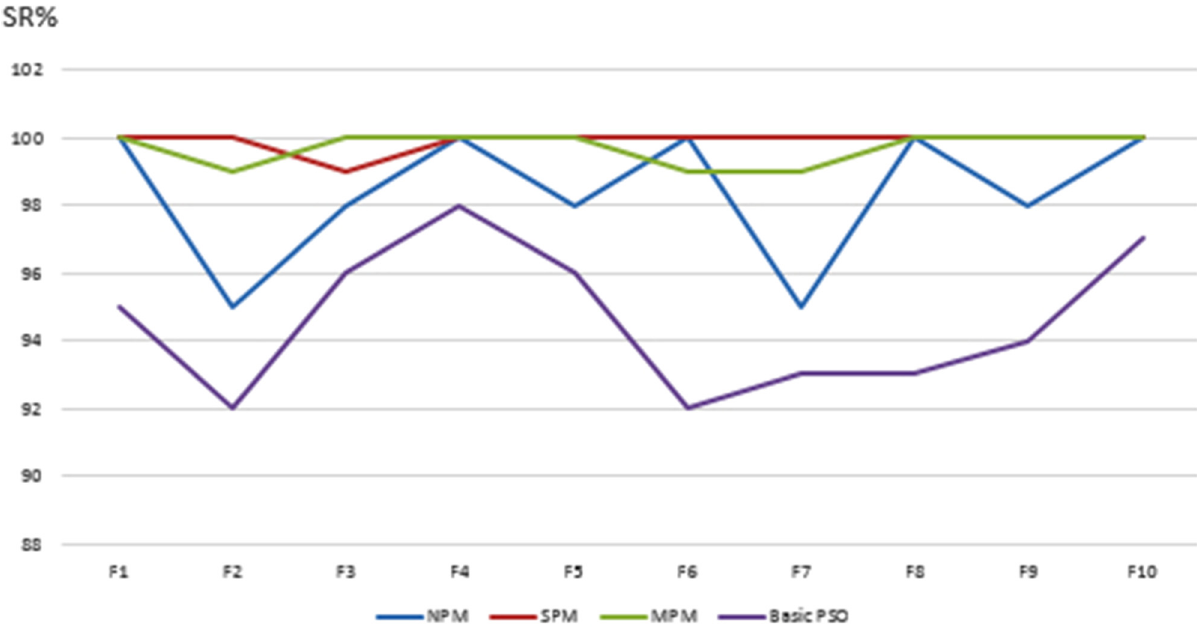
Fig. 8. Success performance curves for NPM, MPM and SPM